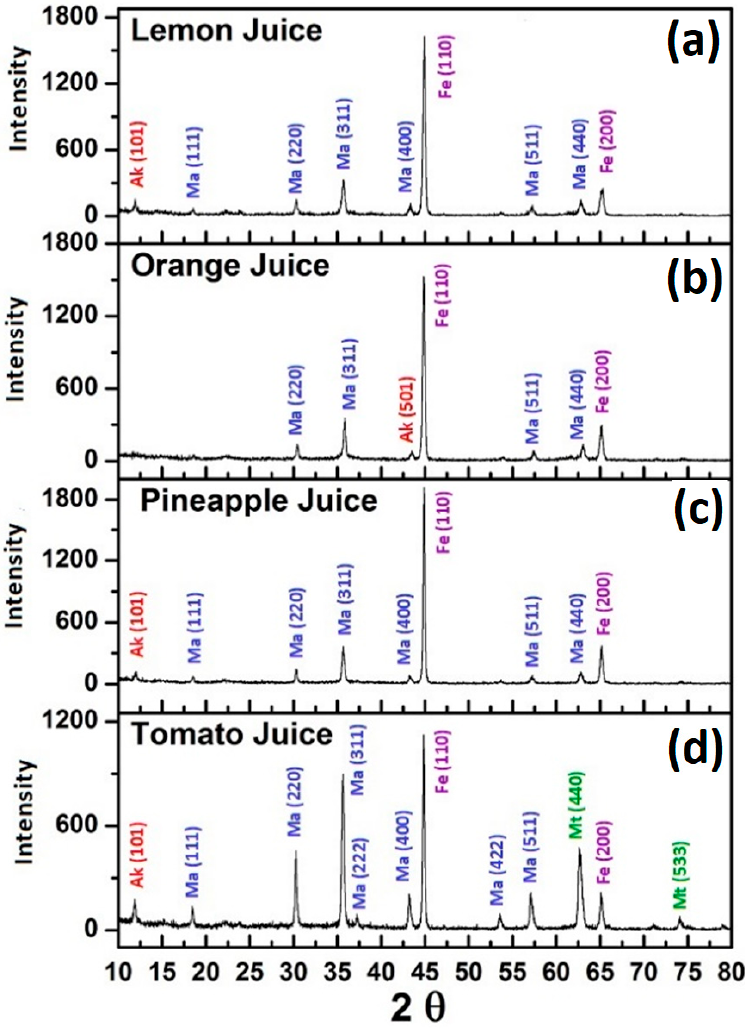
Figure 12. X-ray diffraction patterns acquired from carbon steel (CR1 ≈ EN 1.0338) surfaces after 12 h of immersion in ( a ) lemon juice, ( b ) orange juice, ( c ) pineapple juice, and ( d ) tomato juice, (Ak is Akaganéite, Ma is Maghemite, and Mt is Magnetite).